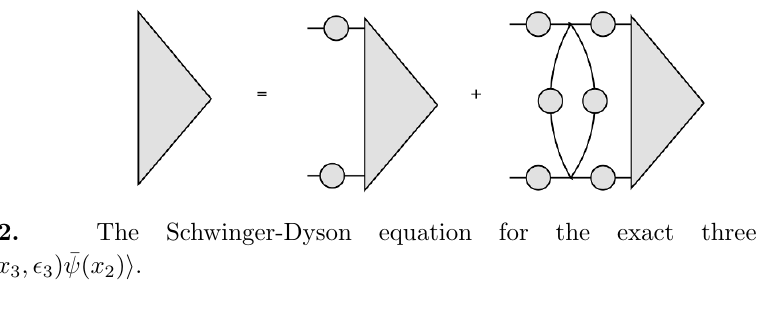
JHEP02(2018)086